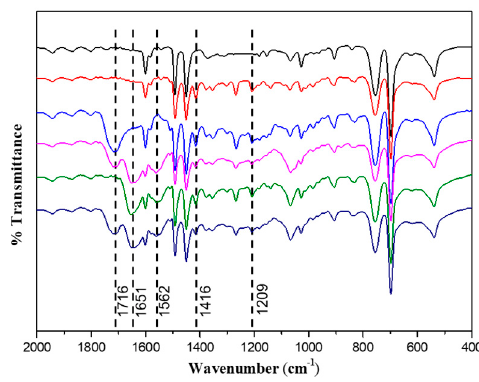
Figure 2. Fourier transform infrared (FTIR) spectra of polymer brushes. Line color denotation: PS seed (black), PSV (red), PSV@PAA (blue), PSV@PAA-b-PHEAA (magenta), PSV@PHEAA (olive) and PSV@PHEAA-b-PAA (navy).